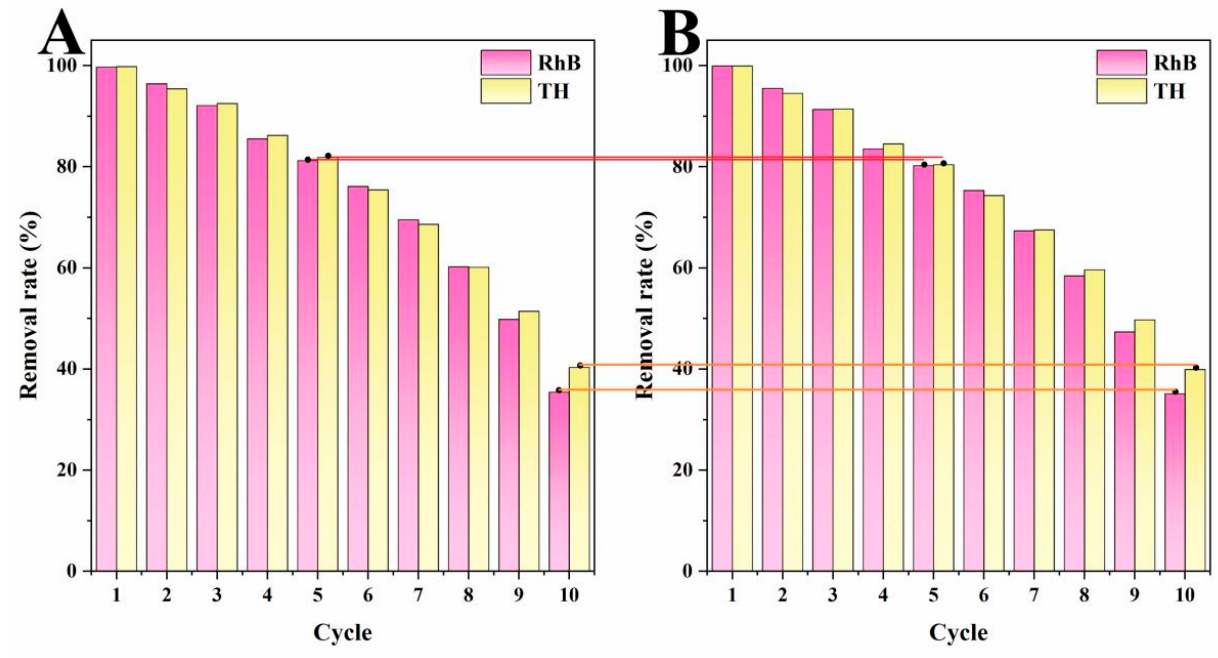
Figure 9. Cycling stability of ( A ) ITGB and ( B ) MITGB. Table 5. Comparison of ITGB and MITGB to RhB and TH with other biochars.